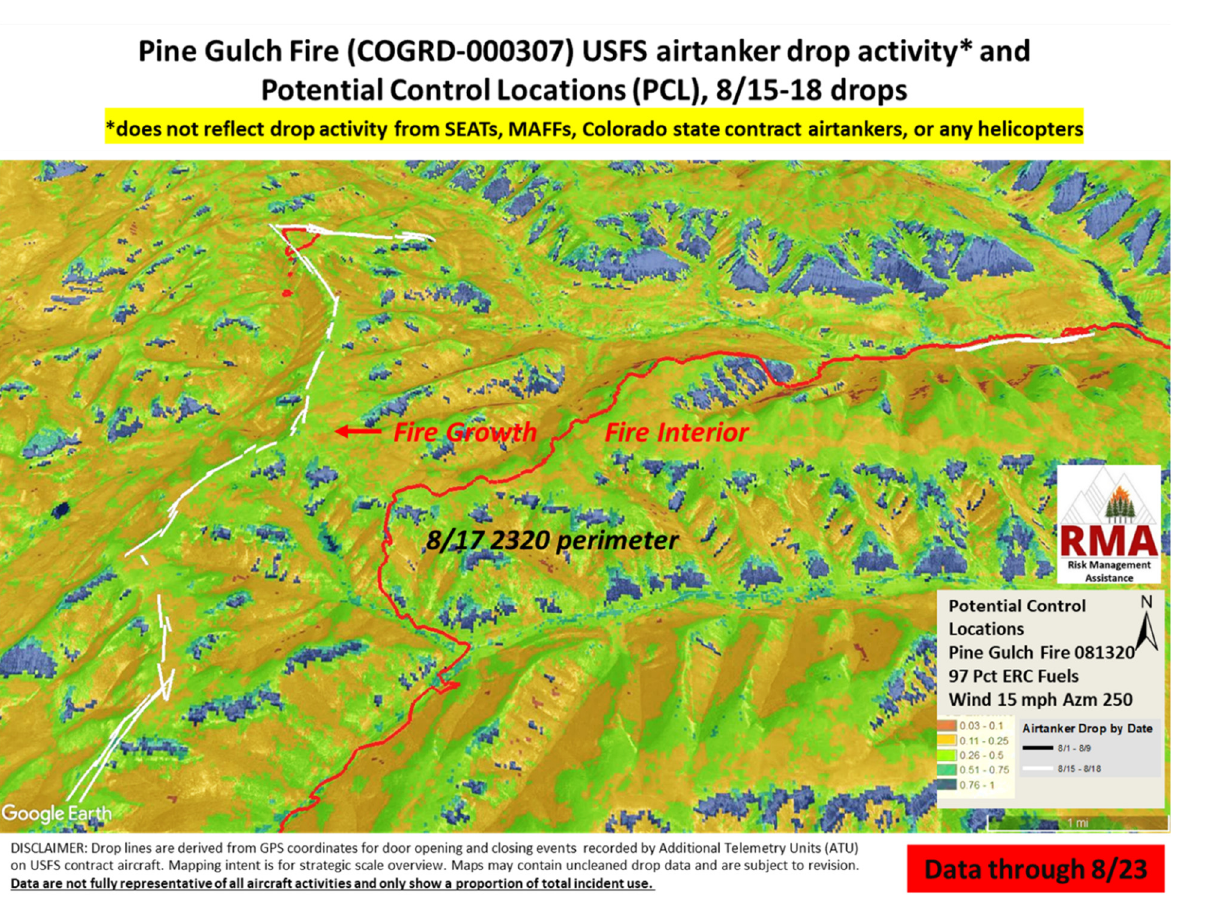
Figure 8. Pine Gulch Fire Aviation Use Summary (AUS) drop location map. Drops are shown as white lines against Potential Control Locations (PCL). The fire perimeter is shown as a red line, measured by infrared flight on 17 August 2020 at 2320 h, local time. For PCL, cool colors represent areas with the highest likelihood of containing the fire. This line of retardant involved 42 drops from 6 different airtankers that supported built line on the ground with roughly 17.4 km and 432,000 L of retardant. COGRD—Colorado Grand Junction Field Office; SEATs—single engine airtankers; MAFFs—Modular Airborne Firefighting Systems; ERC—Energy Release Component; Azm—azimuth.